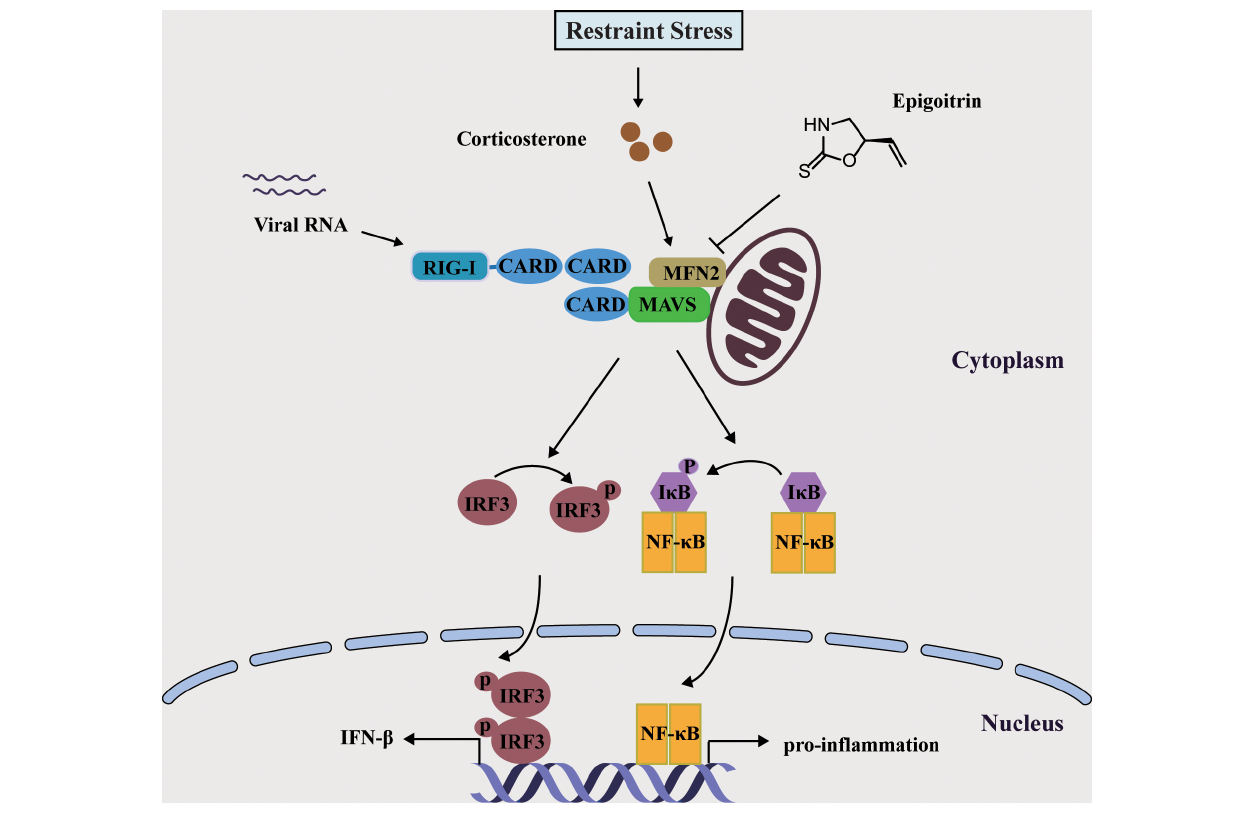
FIGURE 7 | Schematic diagram of the mechanism of Epigoitrin-induced attenuation of H1N1 pathogenesis in the susceptible model.